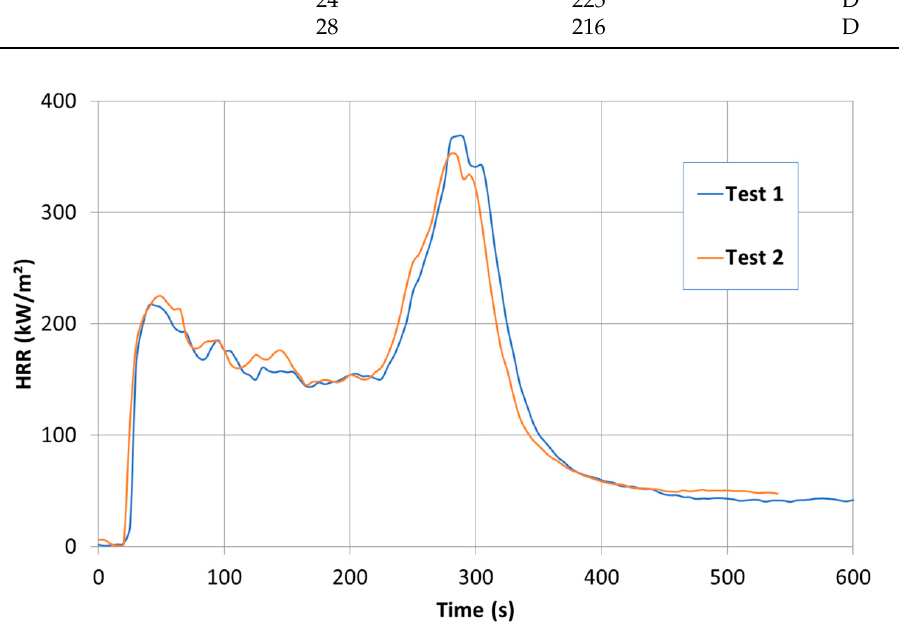
Figure 5. Heat Release Rate (HRR) curves vs. time in the cone calorimeter ISO 5660-1 for untreated plywood.